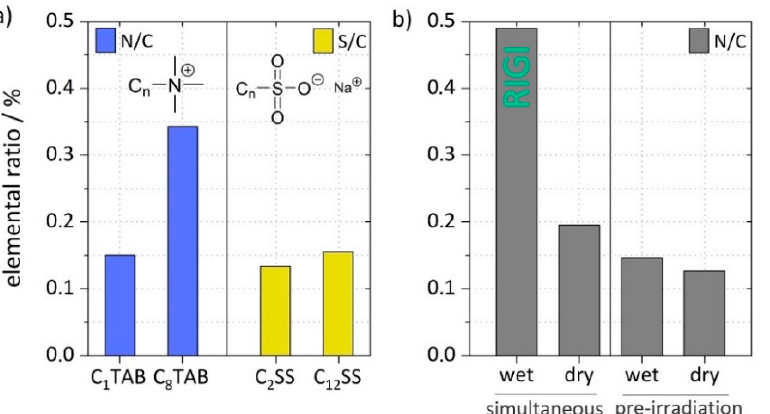
Figure 7. Influence of hydrophobicity, charge, water content, and irradiation method: ( a ) immobi- lization of a cationic and an anionic surfactant each with two different alkyl chain lengths (10 mM, 150 kGy) in order to investigate the influence of hydrophobicity and charge and ( b ) effect of water content and irradiation method on N/C grafting yield (glycine, ω = 0.1%, 150 kGy). XPS data can be found in Table S2.